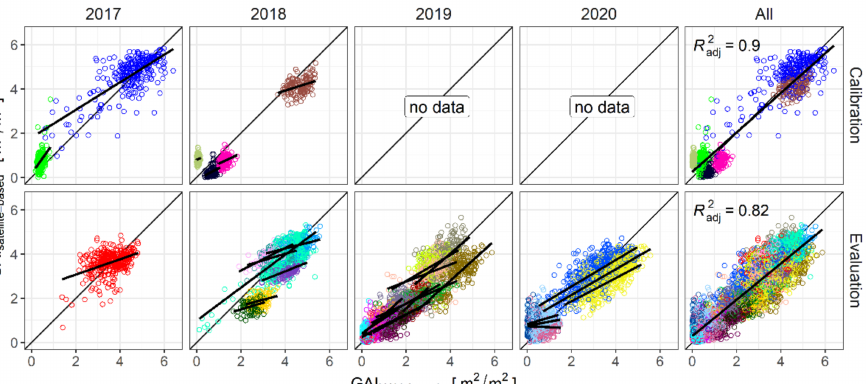
Figure 4. Correlation between UAV- and satellite-based (NIR/RE) predicted GAI for calibration and evaluation, split by years and for the whole datasets. Colors indicate different Sentinel-2 dates. For the single years, the linear regression lines of the different acquisition dates are given, in the comprehensive plot the joint linear regression and the coefficient of determination are